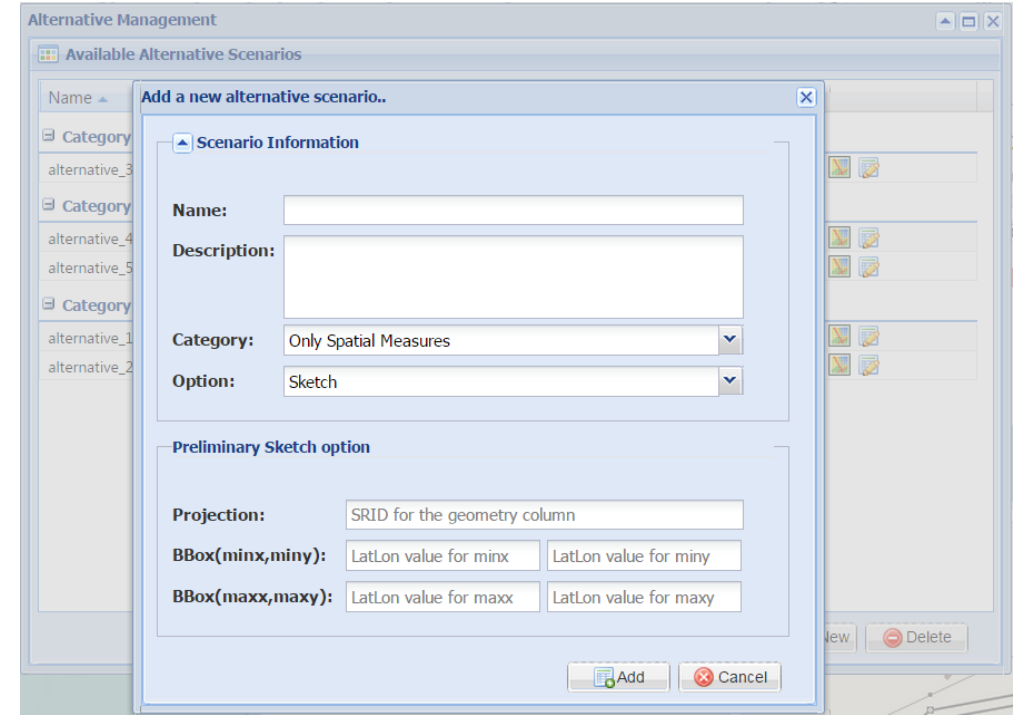
Figure 10. Definition of a new alternative scenario.